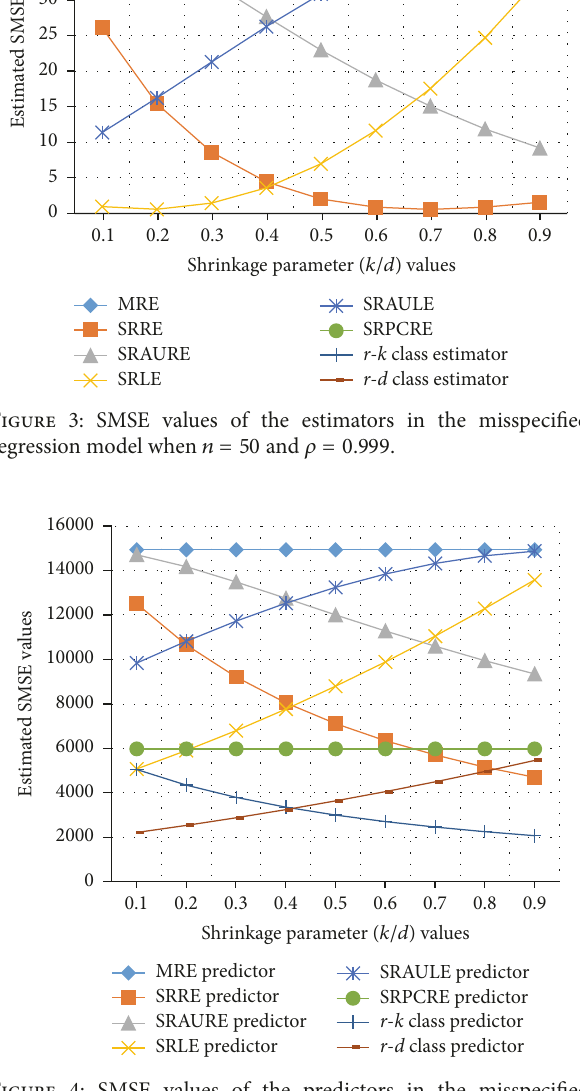
Figure 2: SMSE values of the estimators in the misspecified regression model when 𝑛 = 50 and 𝜌 = 0.99 .